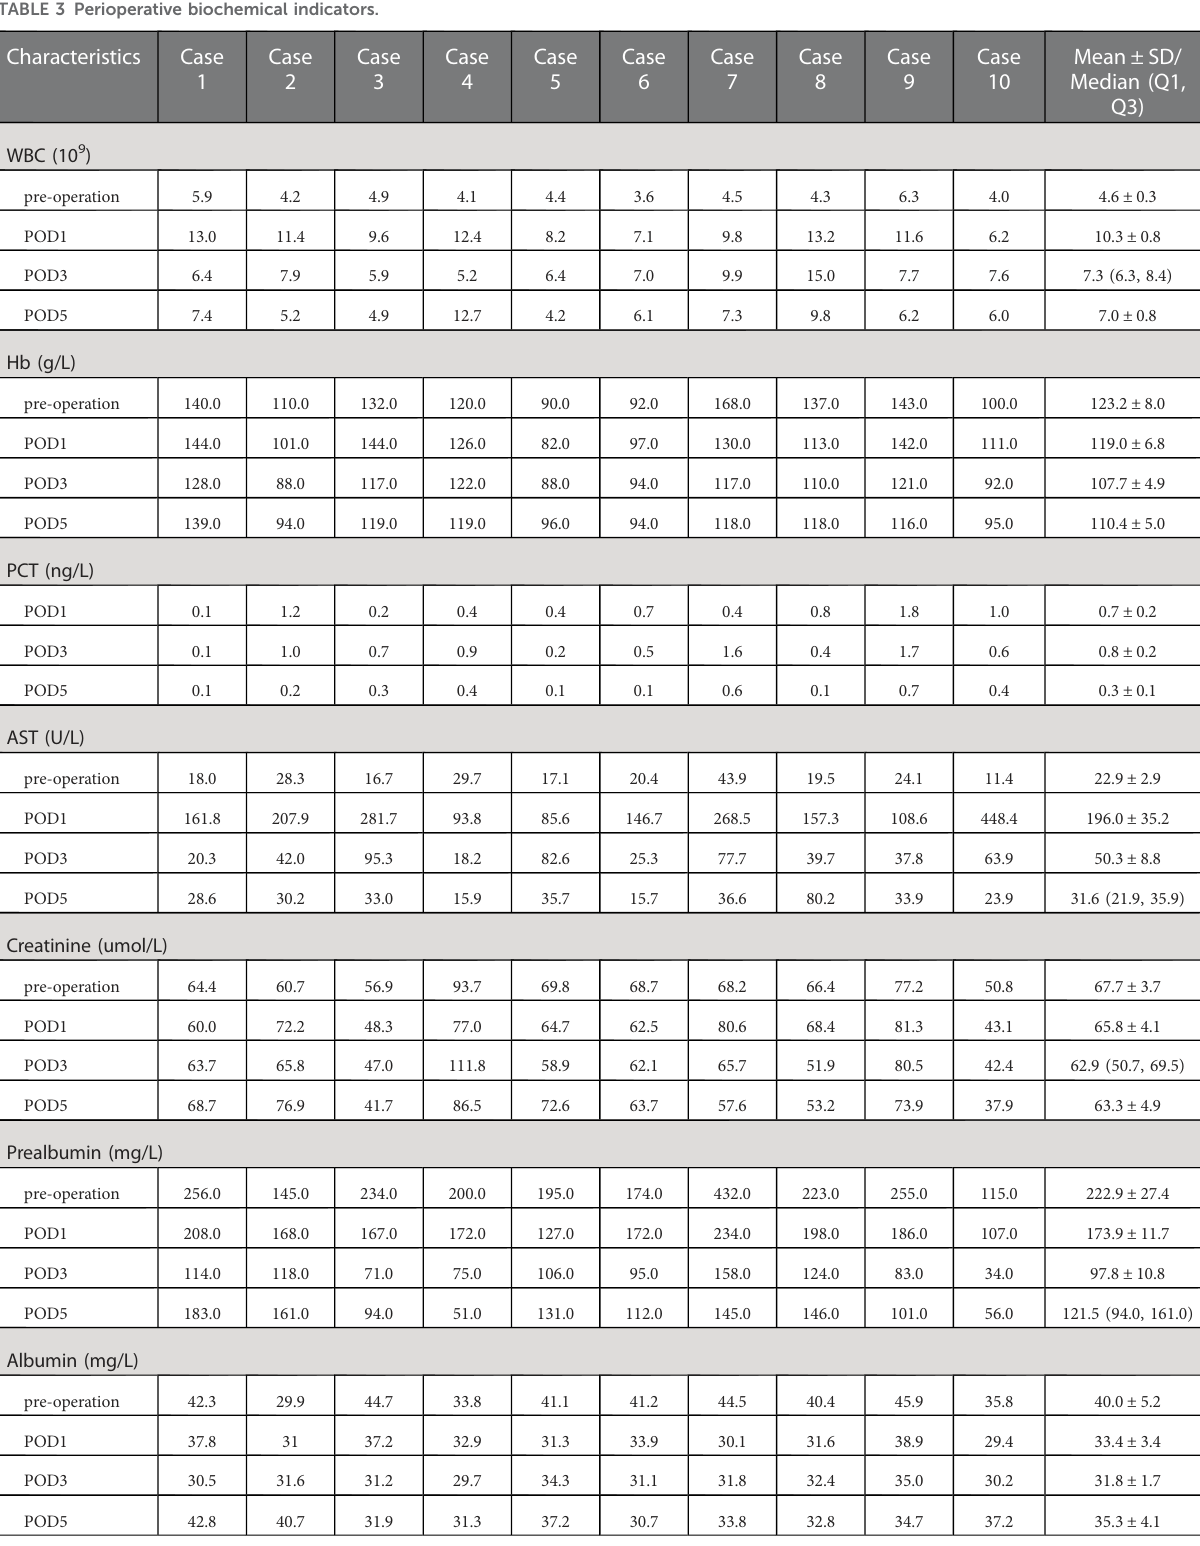
TABLE 3 Perioperative biochemical indicators.